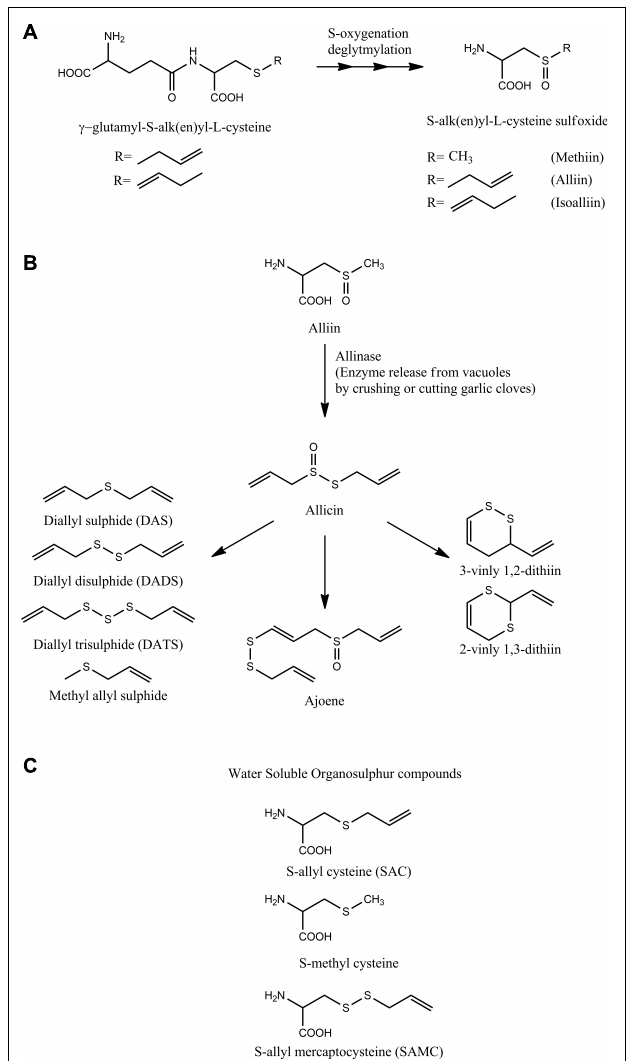
FIGURE 1 | Organosulfur compounds of garlic: The figure shows the major organosulfur compounds present in garlic. (A) The major compounds found in intact garlic cloves. (B) The crushing of garlic clove converts alliin into allicin by the action of allinase enzyme. Allicin is a highly unstable compound that degrades and rearranges itself into different organosulfide compounds shown in the figure. (C) Apart from oil-soluble organosulfur compounds, garlic also has water-soluble organosulfur compounds shown in the